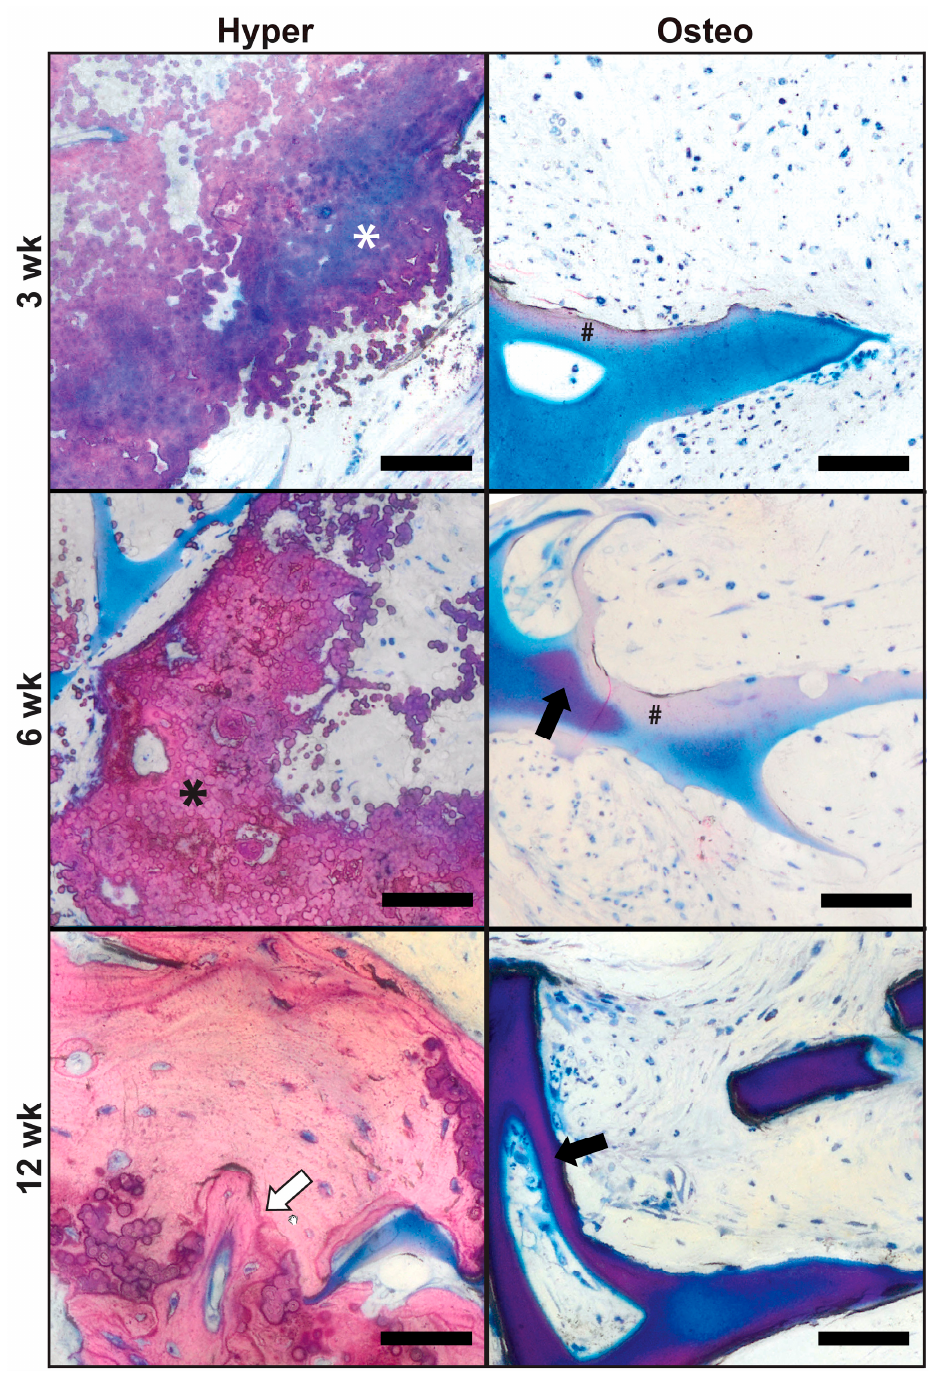
Figure 4. In vivo bone regeneration. The undecalcified bone histology of harvested constructs was conducted following 3, 6 and 12 weeks of implantation. The samples were stained with Levai–Laczko stain to evaluate the presence of mineral and bone regeneration. In the hyper constructs, calcified nodular deposits exhibiting a blue/purple tint (white asterisk) were present at 3 weeks. Continued mineralization and compaction of the extracellular matrix nodules resulted in a change in the tint to a pink color (black asterisk) in the hyper samples at 6 weeks. Mature bone remodeling was indicated by the presence of a cement line (white arrow) in the hyper samples at 12 weeks. In the osteo samples, mineral deposition was initiated in the margins of the silk scaffold, as seen in the samples at 3 and 6 weeks as light pink staining (black hash sign). Dense scaffold mineralization in the osteo samples was present in limited amounts at 6 weeks (dark purple stain, indicated by the black arrow) and was more widespread at 12 weeks, consistent with the µCT evaluation. Scale bars: 50 µm.